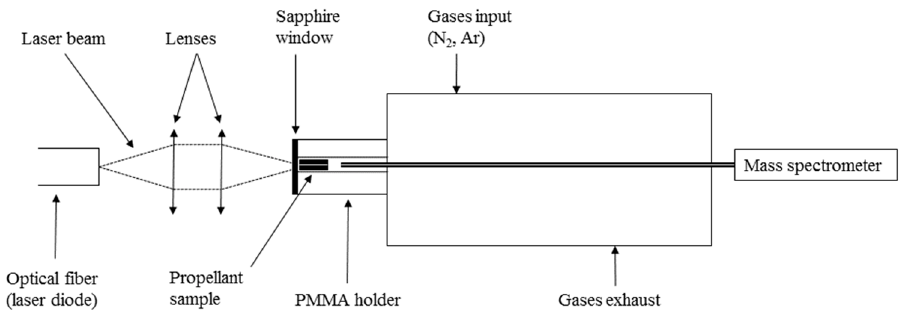
Figure 16. Scheme of the laser-induced pyrolysis setup.